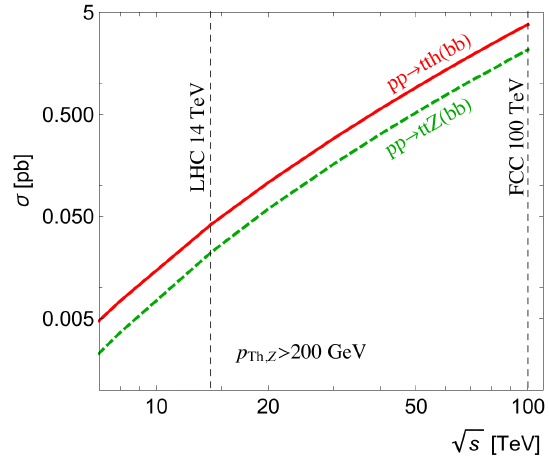
Figure 6 . Cross-section for pp → t ¯ th and pp → t ¯ tZ production at the parton level as a function of the pp collider energy. We require the Higgs and Z bosons in the boosted regime, p Th,Z > 200 GeV, and account for their branching ratios to a bottom-quark pair, BR ( h, Z → b ¯ b ) . Top quarks are set